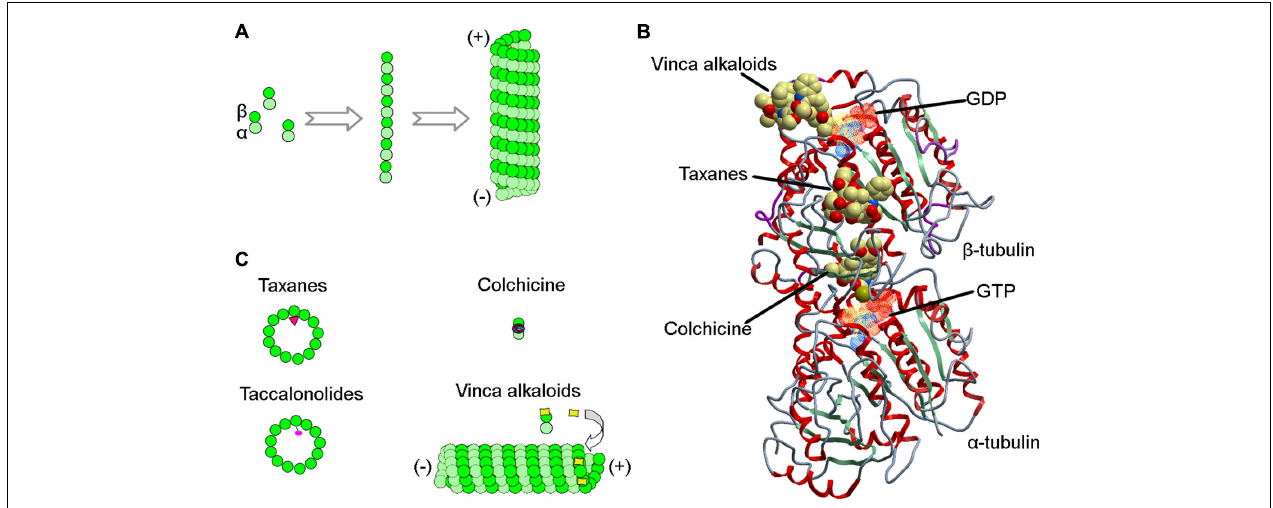
FIGURE 1 | Interactions of MTAs with microtubules. (A) During microtubule polymerization, α / β -tubulin heterodimers assemble head-to-tail to generate protofilaments, which form lateral connections to build the hollow structure of the microtubule. (B) Structure of the α / β -tubulin heterodimer showing binding sites for taxanes, vinca alkaloids, colchicine, GDP, and GTP. (C) Schematics showing how taxanes, vinca alkaloids, colchicine, and taccalonolides are incorporated into microtubules or α / β -tubulin